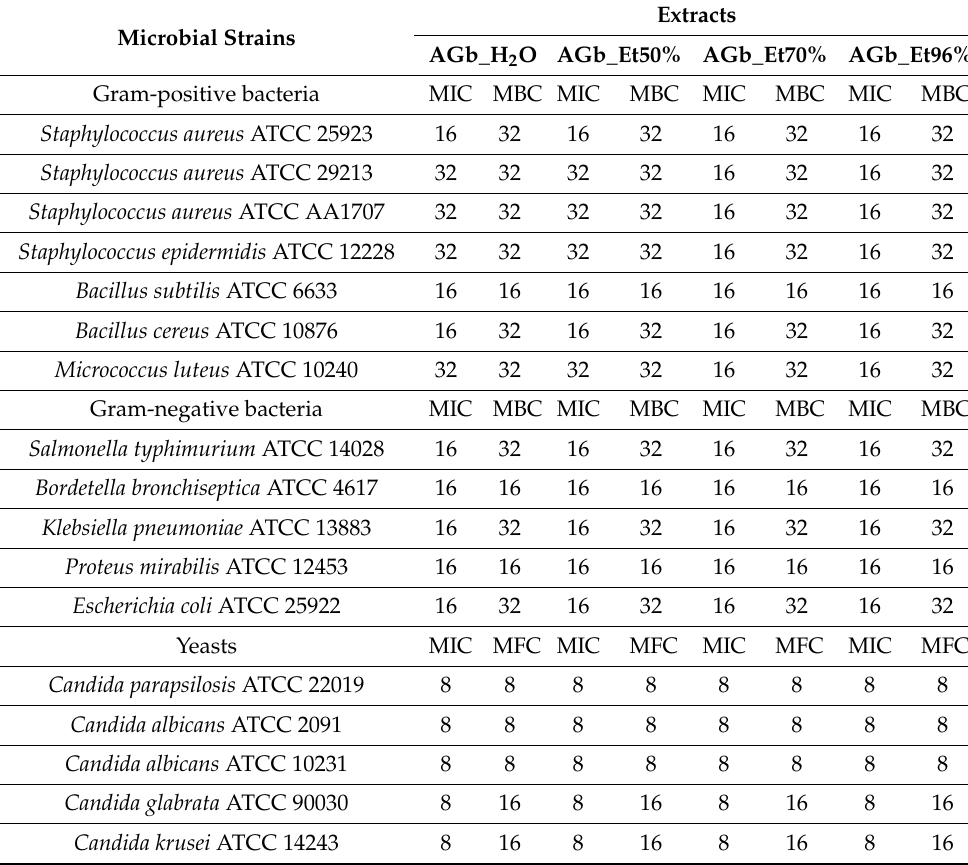
Table 4. MIC (mg/mL) and MBC (mg/mL) and MFC (mg/mL) values of different dried extracts obtained from Allium galanthum against the reference strains.